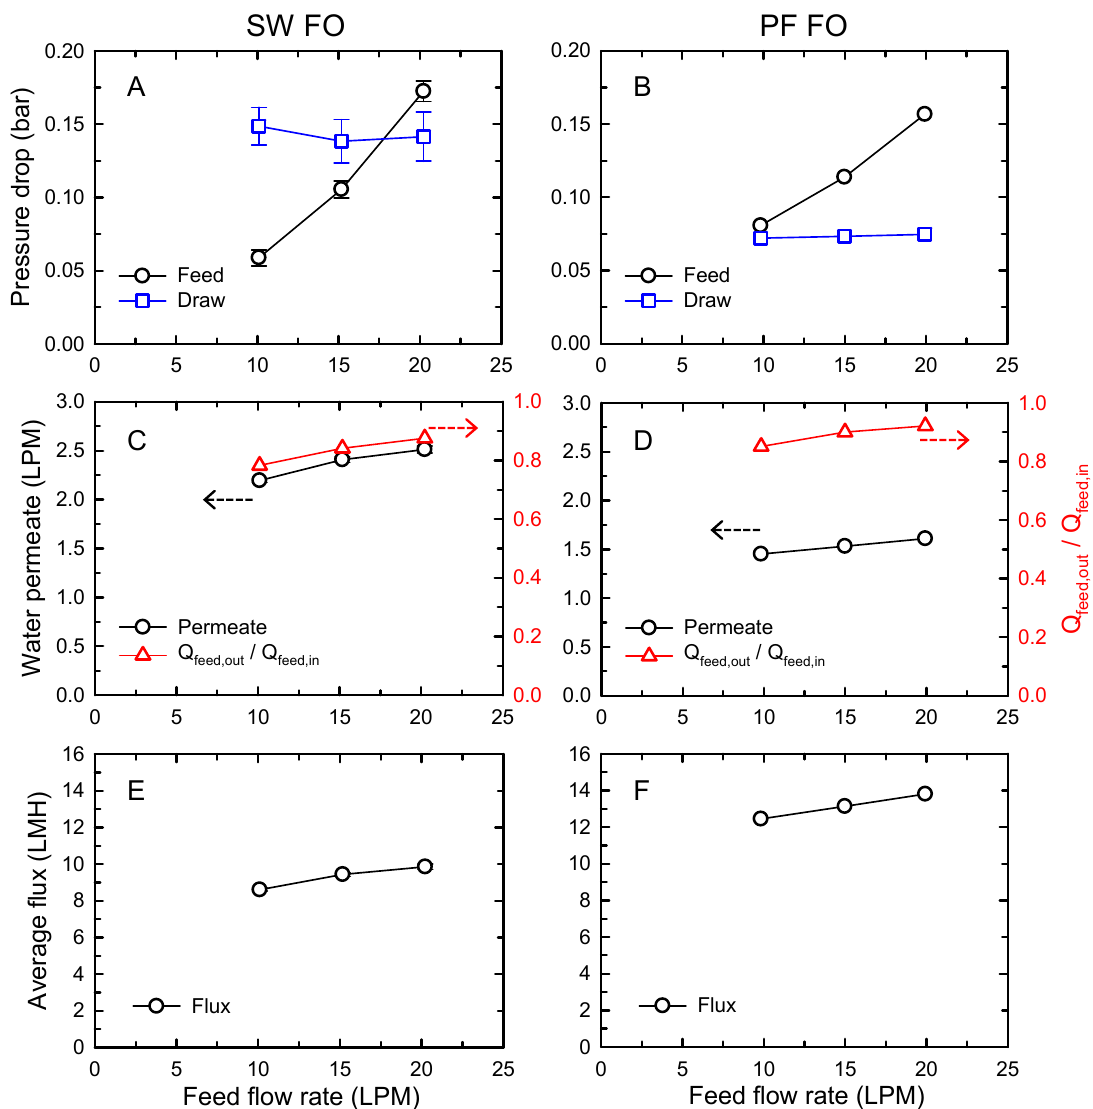
Figure 3. Performance of a forward osmosis (FO) element as a function of feed flow rates: spiral-wound (SW) FO ( A , C , E ) and plate-and-frame (PF) FO ( B , D , F ) elements. Pressure drops in feed and draw channels (top), the water permeate and normalized feed flow volume ( Q feed, out / Q feed, in ) at the outlet (middle), and the average flux (bottom). The draw flow rate was fixed at 5 LPM. The concentrations of feed and draw solutions were 10 and 70 g/L, respectively.